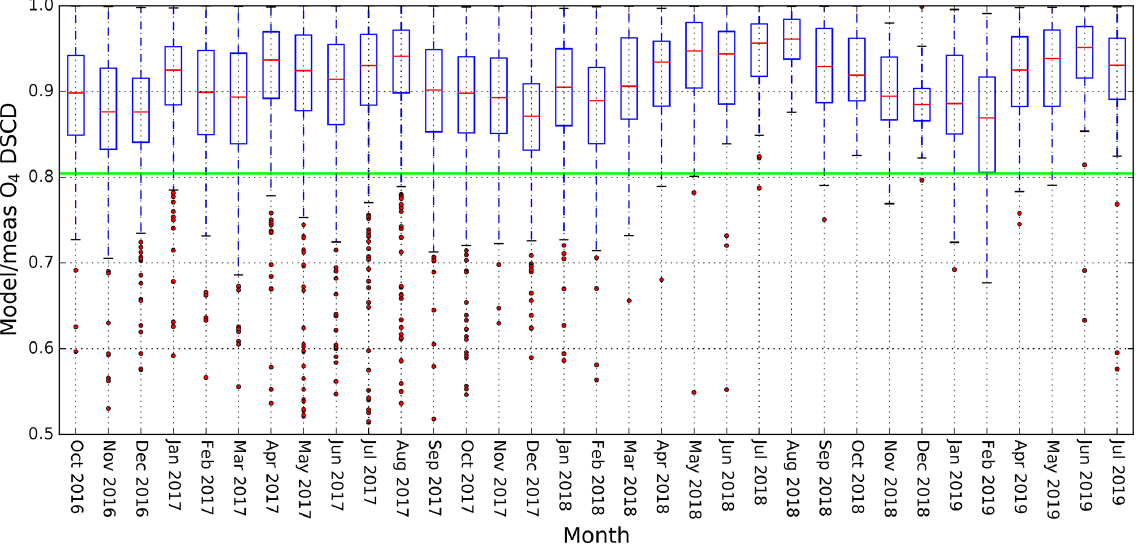
Figure A1. Monthly statistics of measured O 4 DSCDs exceeding the pure Rayleigh simulation. The ratios between modeled and measured O 4 DSCDs for observations taken at an elevation angle of 15 ◦ are shown. The green line indicates the 10th percentile (0.804).